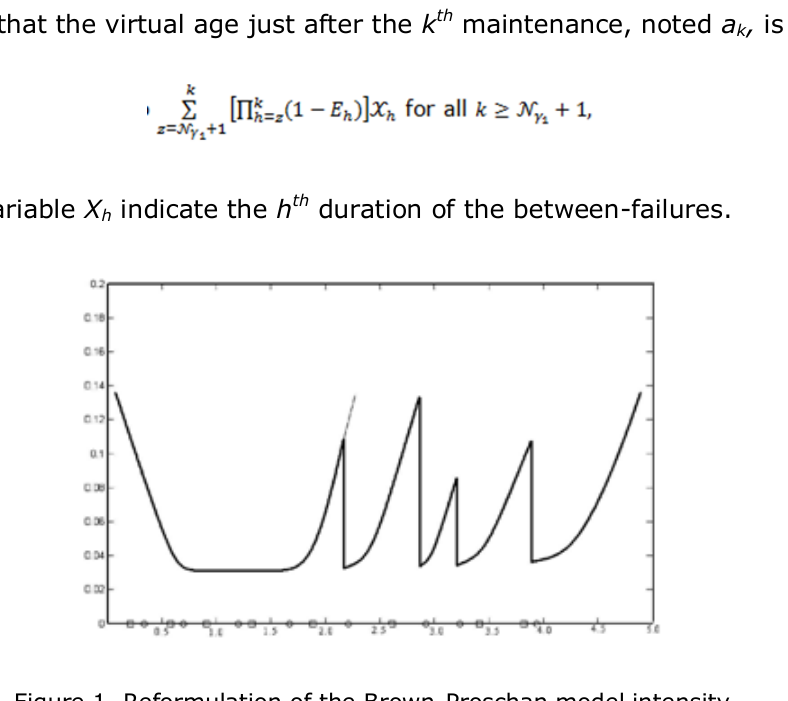
Figure 1. Reformulation of the Brown-Proschan model intensity The figure1 translated the trajectory of this intensity for an unspecified value of p between 0 and 1. In this figure, the instants of perfect and minimal maintenances are represented on the x-axis respectively by circles and